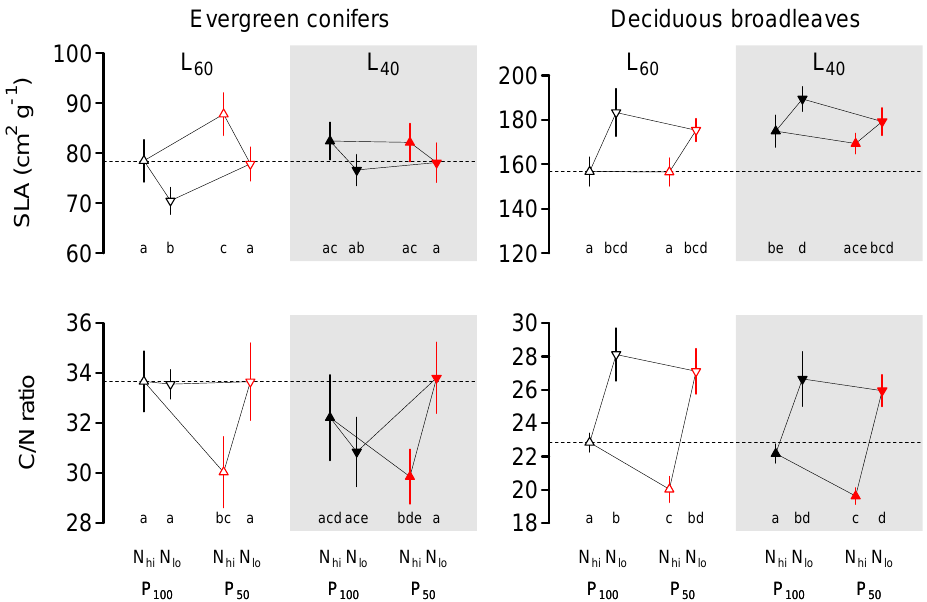
Figure 1. Specific leaf area (SLA) and the C / N ratio (means ± SE) of the foliage of evergreen conifer and deciduous broadleaved seedlings grown for three years under fully crossed combinations of ambient (P 100 , black symbols) or reduced precipitation (P 50 , red symbols), high (L 60 , open symbols) or low PAR (L 40 , filled symbols), and high (N hi , upwards triangle) or low (N lo , downwards triangle) soil nutrient availability. The dashed line indicates foliar traits under optimal resource availability, i.e., L 60 × P 100 × N hi . Different letters below the means indicate significant differences between treatment combinations within species group (Tukey adjusted least square means).